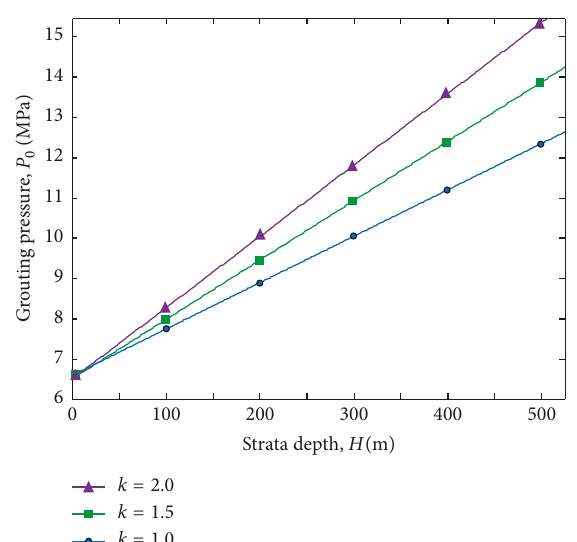
Figure 6. When σ